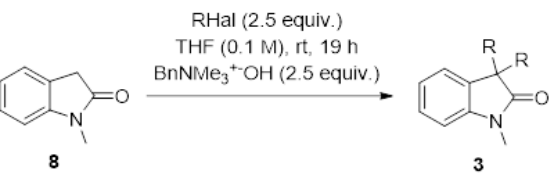
Figure 5 - Synthesis of 3,3-disubstituted oxindole 3 from N -methyloxindole ( 8 ).